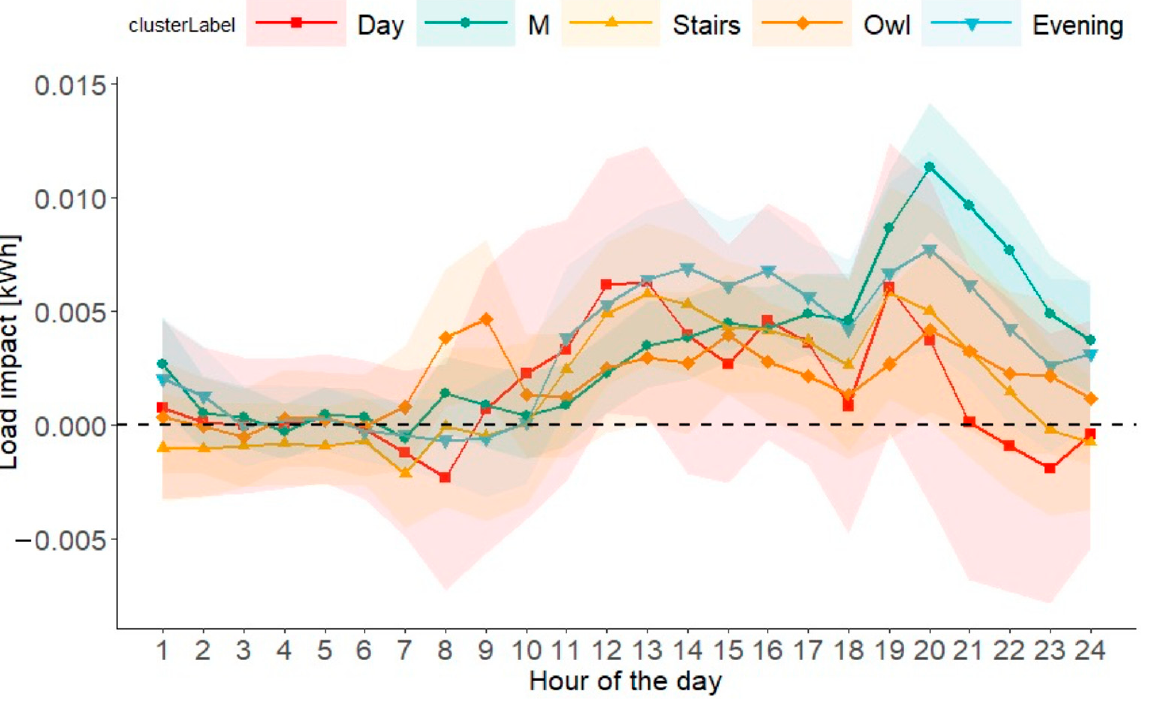
Figure 6. Change in load shape groups’ household hourly energy consumption due to increase in the time-varying reproduction number of COVID-19.